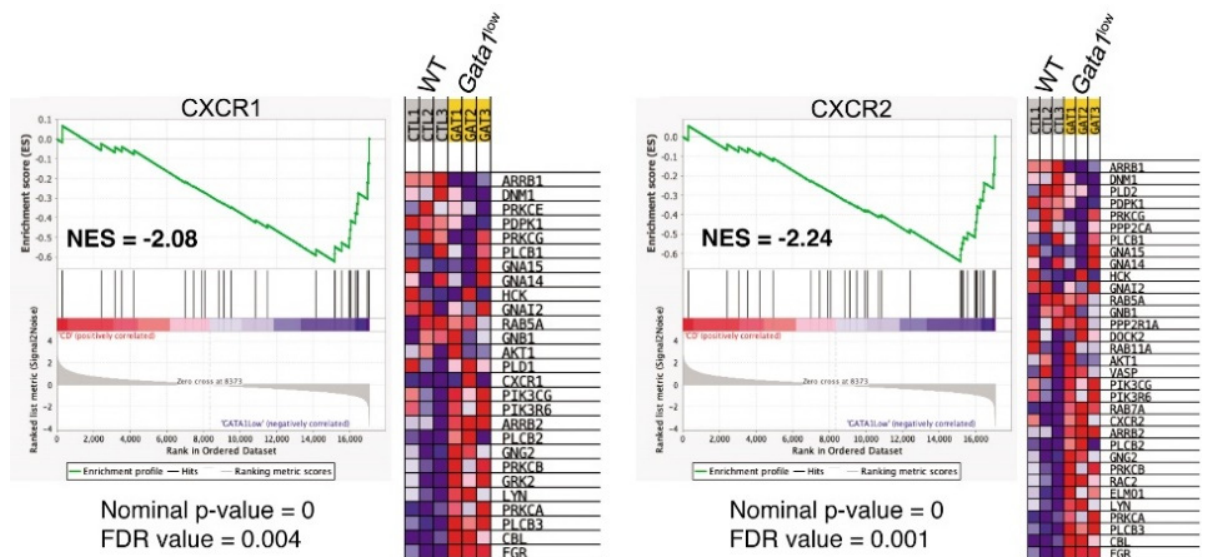
Figure 7. Both CXCR1 and CXCR2 gene signatures are enriched in Gata1 low bone marrow. Gene set enrichment analysis (GSEA) for the CXCR1 and CXCR2 signatures and heat maps of differentially expressed genes of the CXCR1 and CXCR2 pathway. Abbreviations: CXCR1 and 2: CXC motif chemokine receptor 1 and 2; WT: wild-type; MKs: megakaryocytes; FDR: false discovery rate.